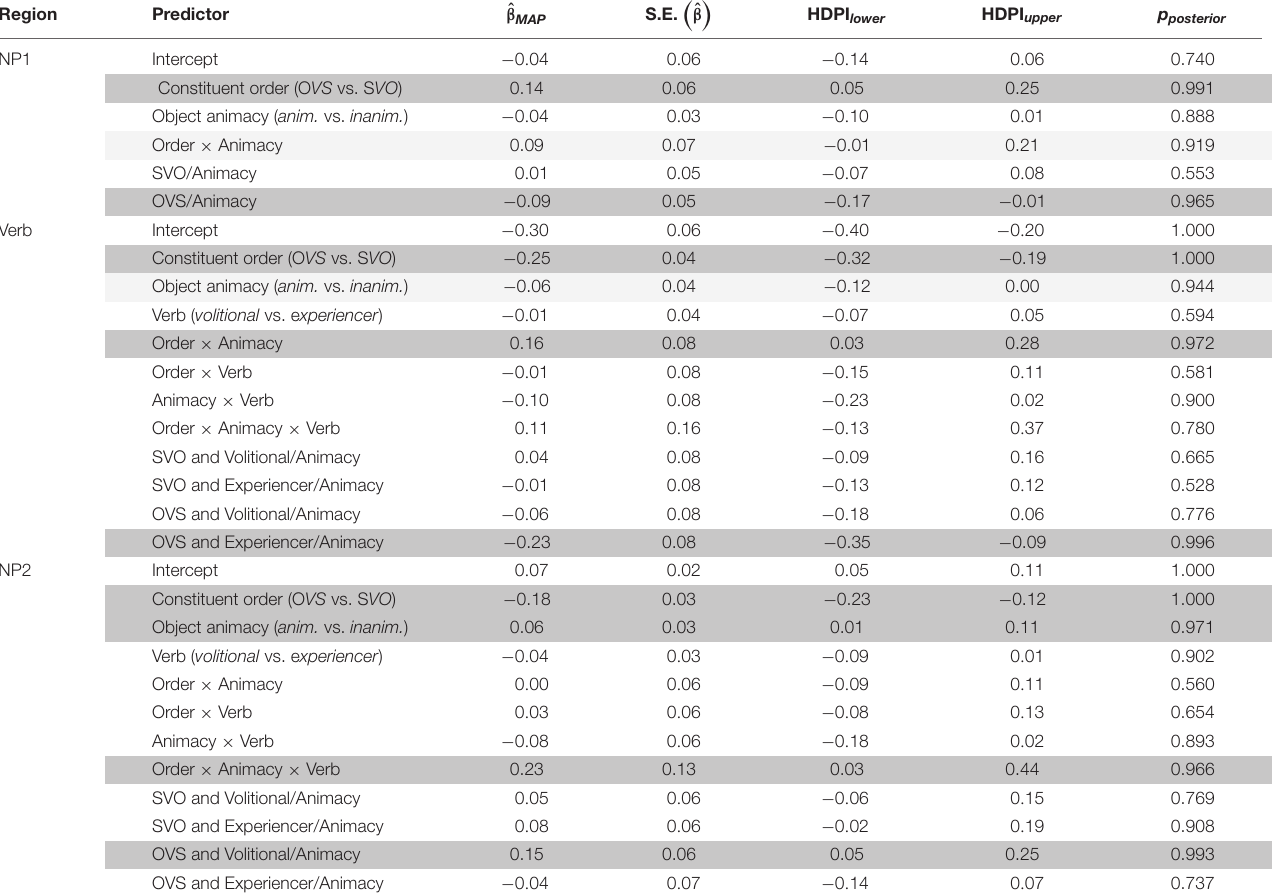
TABLE 4 | Results of the Bayesian linear mixed-effects regressions (LMMs) of region-averaged length-corrected RTs investigating the effects of linguistic cues over the NP1, verb, and NP2 region. Region Predictor ˆ β MAP S.E.